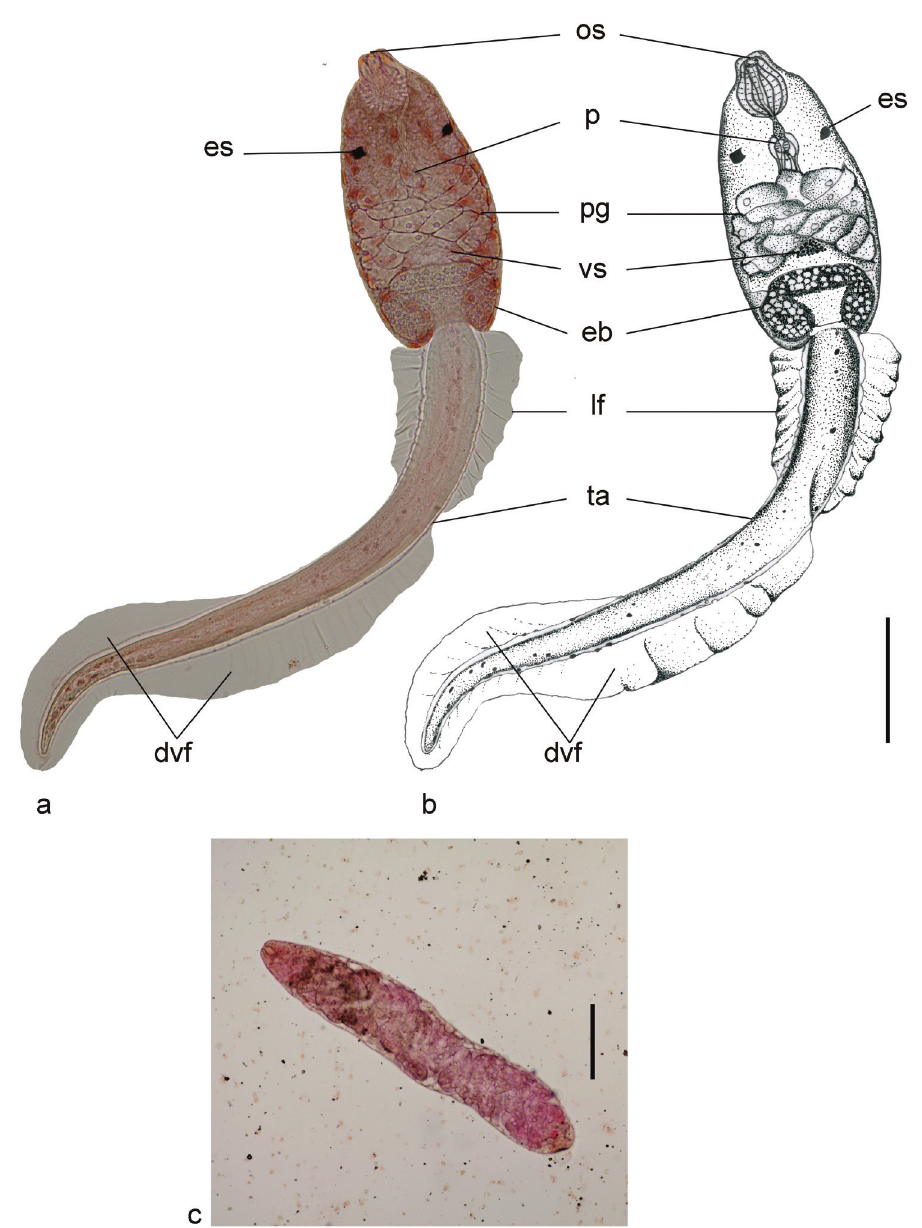
Figure 10. Stictodora tridactyla Martin & Kuntz, 1955. a . specimen stained with 0.5% neutral red. b . drawing of cercaria. c . redia stained with 0.5% neutral red. Abbreviations – dvf: dorsal finfold; eb: excretory bladder; es: eyespot; lf: lateral finfold; os: oral sucker; p: pharynx; pg: penetration gland; ta: tail; vs: ventral sucker. Scale bars: 50